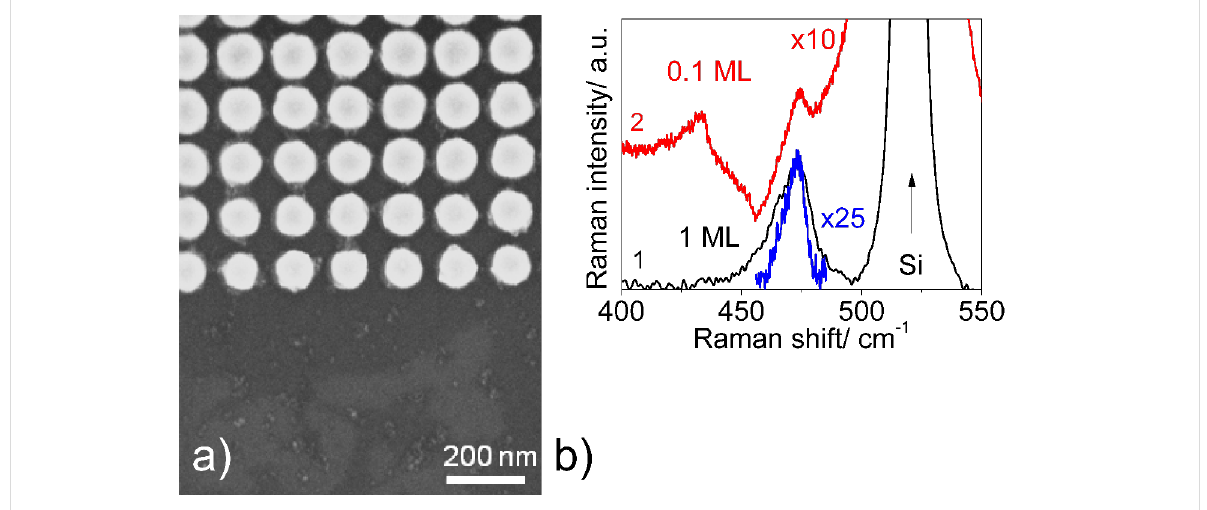
Figure 6: a) SEM image of CuS NCs with an ultra-low areal density deposited on Au arrays on SiO 2 layer and b) SERS-IERS Raman spectra measured with 632.8 nm. SERS spectrum of CuS NCs with 1 ML coverage on Au arrays formed on SiO 2 layer (curve 1) together with the Raman response of the CuS NCs of ultra-low areal density (denoted as 0.1 ML, curve 2). The 25 times enlarged fragment of curve 2 is shown for